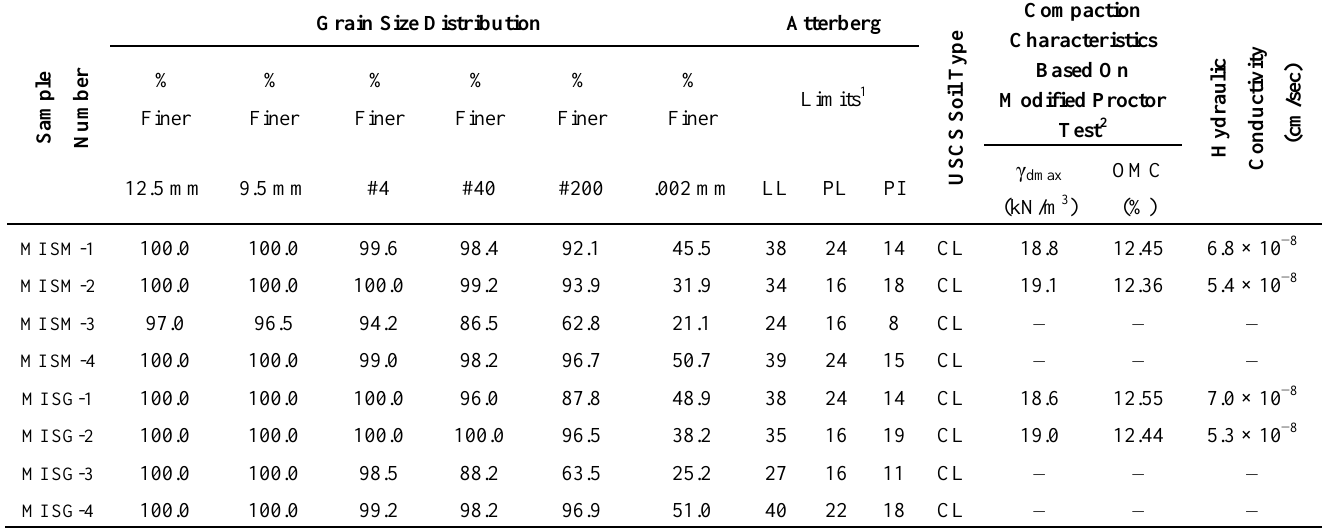
Table 4. Geotechnical characteristics of stockpiled mined clay-samples from Southwest Michigan processed manually and using a soil